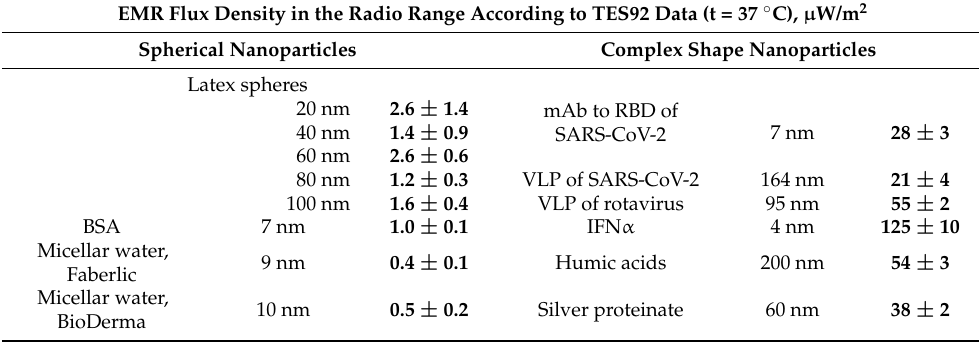
Table 2. The thermal radio emission of nanoparticle solutions depends on their shape. The aliquot was 100 µ L of aqueous solutions of nanoparticles. The concentration of nanoparticles in aqueous solution was 10 µ g/mL. The concentration of silver proteinate in paraffin was 0.05% in terms of the Ag content. The concentration of humic–fulvic acids was 73 mg of dry residue in 1 mL. EMR Flux Density in the Radio Range According to TES92 Data (t = 37 ◦ C), µ W/m 2 Spherical